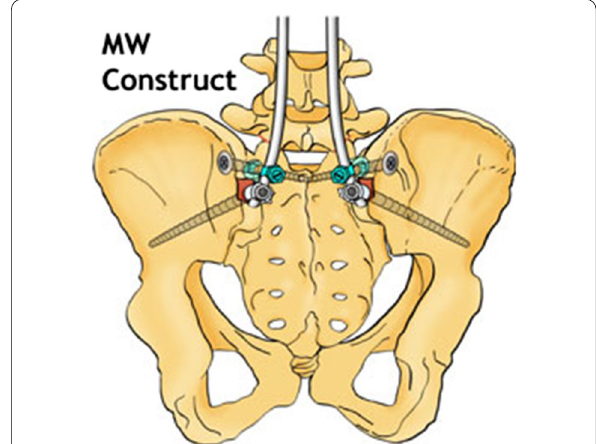
Fig. 14 MW spinopelvic construct